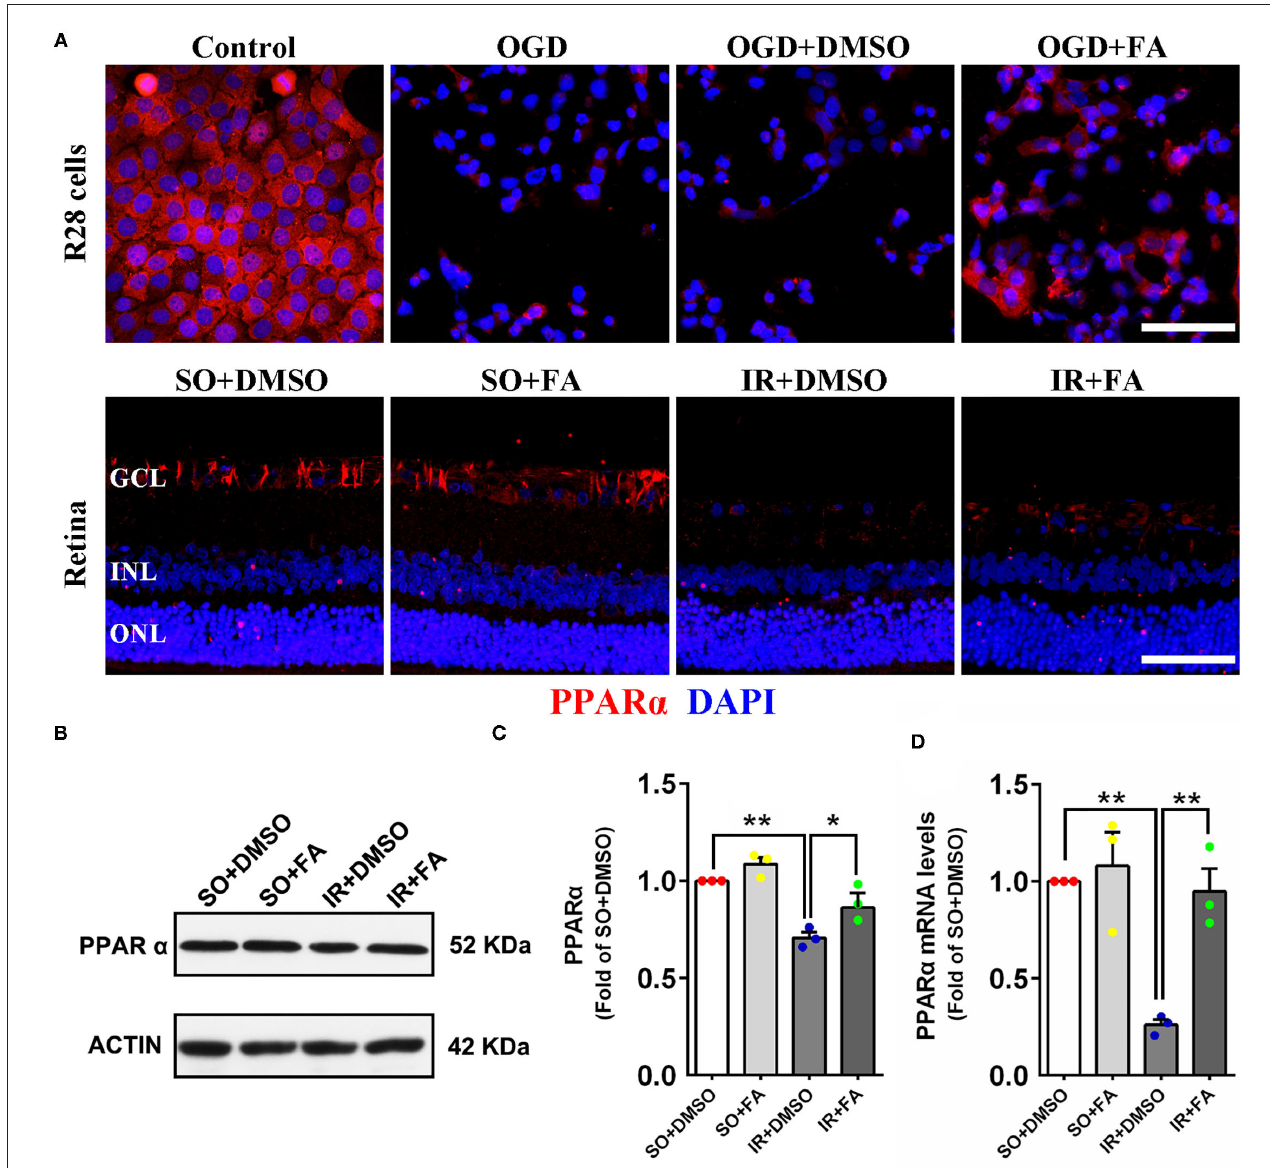
FIGURE 5 | Fenofibric acid increased PPAR α expression in OGD-treated R28 cells (2h post-modeling) and IR-treated retinas (24h post-modeling). (A) Representative photomicrographs of immunostained PPAR α (red) and nuclei (blue; counterstained by DAPI) in R28 cells and retinas. (B) Retinal expression of PPAR α and actin detected by western blotting. (C) Average expression of PPAR α semi-quantified by densitometry and normalized by actin levels. (D) Average expression of PPAR α mRNA detected by Real-time PCR and normalized by GAPDH mRNA levels. Data are the mean ± SEM; * p < 0.05; ** p < 0.01. Scale bar = 50 µ